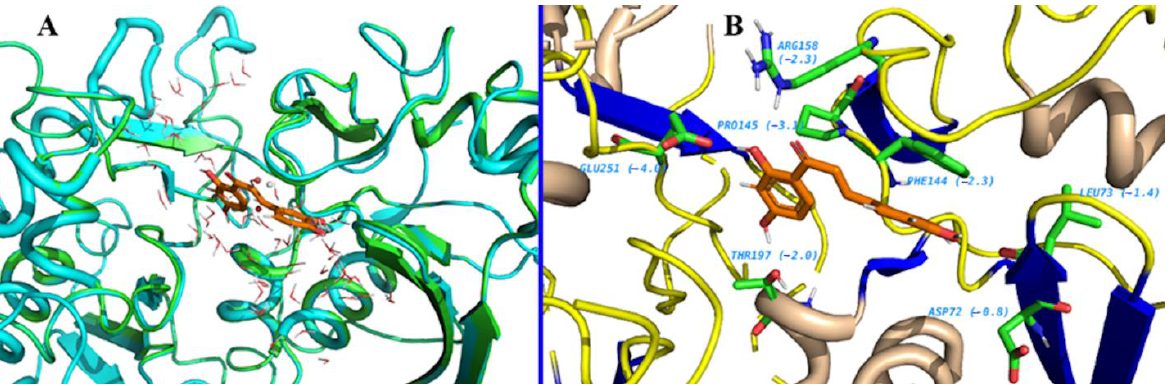
Figure 9. ( A ) The induced conformational changes upon ligand (quercetin) binding. The protein is shown as a cyan cartoon before binding of the ligand, and the conformational changes are shown in green. ( B ) The regions of the pocket that favor ligand chemistry are shown as green sticks. The free energy ( ∆ G) of each amino acid is shown in parenthesis; the more negative, the better.